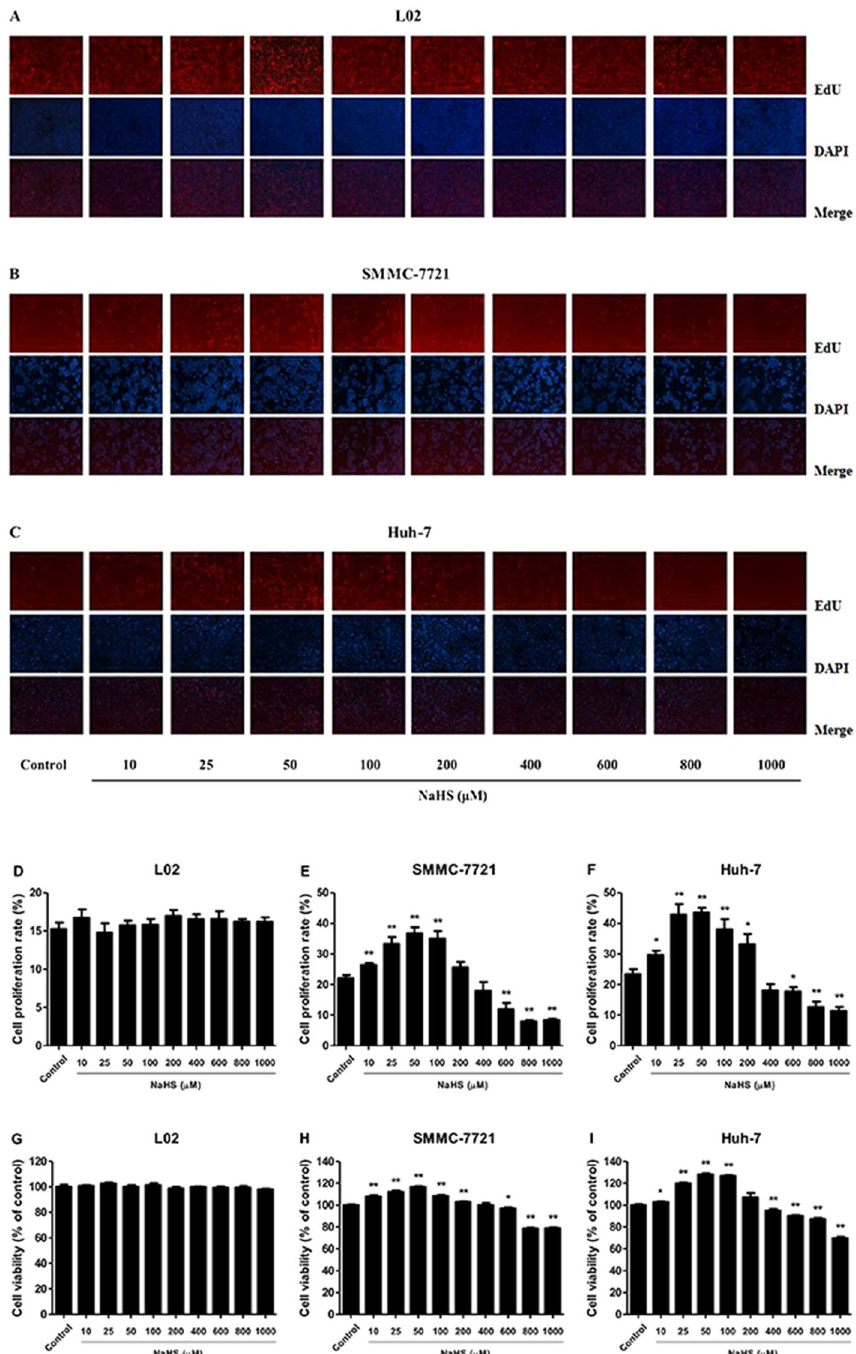
Figure 2. Effect of H 2 S on the proliferation and viability of human normal hepatocytes and HCC cells. ( A – C ) DNA replication activities of human normal hepatocytes and HCC cells in each group were examined by EdU assay; original magnification 200x. ( D – F ) The proliferation rate of each group was analyzed. ( G – I ) The percentages of viable cells were determined using MTT assay and the cell viability of every cell line without NaHS treatment was normalized as 100% and considered to be the control group. Data are presented as mean ± SEM of three independent experiments; * P < 0.05, ** P < 0.01 compared with the control